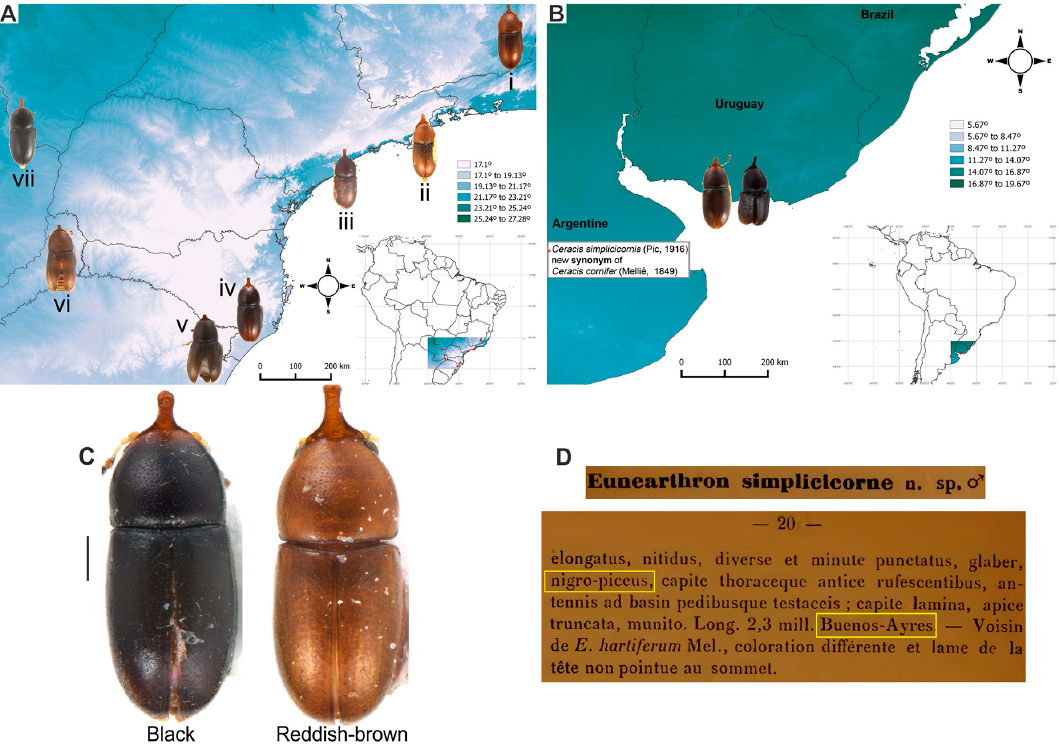
Figure 6. Colour variation in individuals of Ceracis cornifer (Mellié). ( A ) Localities in a temperature map (in Celsius degrees): (i) Viçosa, MG (Brazil), (ii) Ilha da Vitória, SP (Brazil), (iii) Peruibe, SP (Brazil), (iv) Urubici, SC (Brazil), (v) São Francisco de Paula, RS (Brazil), (vi) Wanda, Misiones (Argentina), (vii) Paranhos, MS, Brazil. ( B ) Specimens from the southern tip of the distribution. ( C ) Coloration black and reddish-brown. ( D ) Original description of C. simplicicornis Pic (new synonym of C. cornifer proposed here) from Buenos Ayres as “nigro-piceus”. Diagnosis. Each lateral contour of male frontoclypeal horn usually bears a pronounced inflection near base; the horn is elongate, with rounded to subtruncate apex. The antennal funicle has four antennomeres in which the first is shorter than the next three together. The pronotum is convex with a broadly rounded anterior edge. The anterior portion of each hypomeron has a slightly rounded outer edge. The tegmen has a narrow inner emargination at the apical edge which is less than one half of the total length of the tegmen; its outer edges bear an inflection at the first basal one half; each lobe of the apical portion has one small denticle at the inner apical edge and a slight notch on the outer portion.